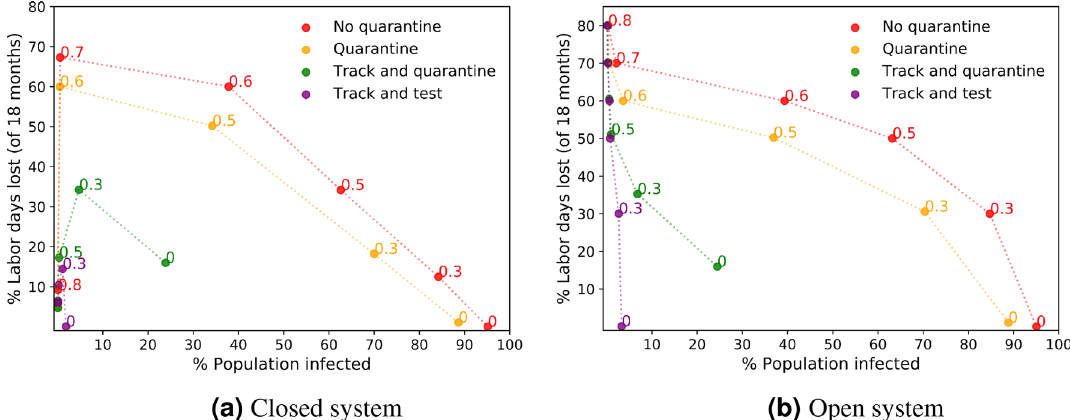
Figure 3. Tracking compared with the Quarantine method and the no-quarantine benchmark.